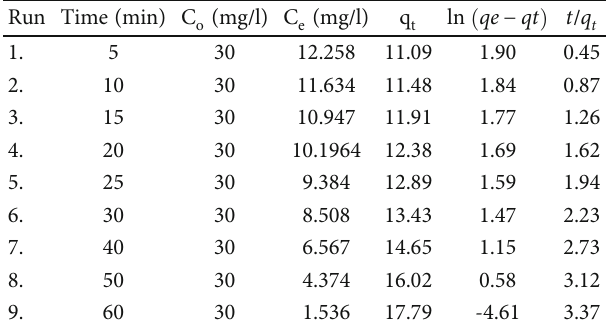
Table 14: Laboratory data for adsorption of Cr(VI) kinetics models.